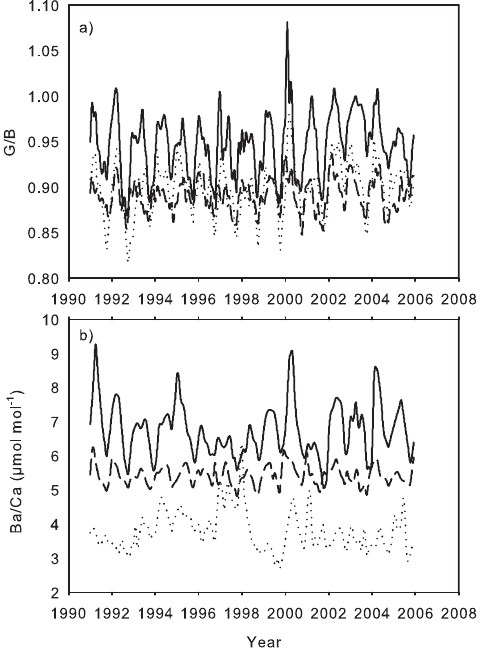
Fig. 5. Cross–core comparison of monthly G/B (a) and Ba/Ca (b) absolute values for the complete 15yr time-series of the three cores MAS1 (solid), ANDRA (dotted) and IFAHO (dashed).